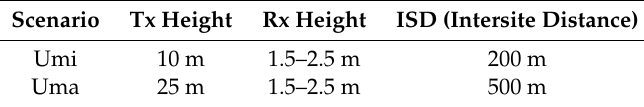
Table 1. Basic parameters in UMi and UMa.